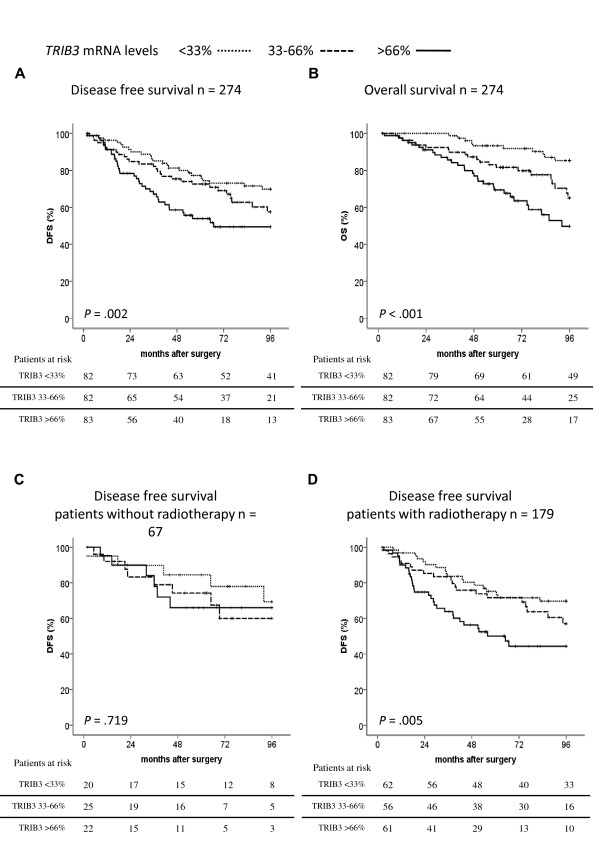
TRIB3 expression is associated with poor prognosis in breast cancer. Patients where divided into three groups based on their TRIB3 mRNA levels; less than 33% (dotted line), 33% to 66% (dashed line) and more than 66% (solid line). Kaplan-Meier plots of (a) disease-free survival (DFS; P = 0.002) and (b) overall survival (OS; P < 0.001) in breast cancer patients (n = 274) and DFS (c) in patients with mastectomy without further radiotherapy (n = 67, P = 0.719) and (d) in patients that received postoperative radiotherapy (n = 179, P = 0.005).